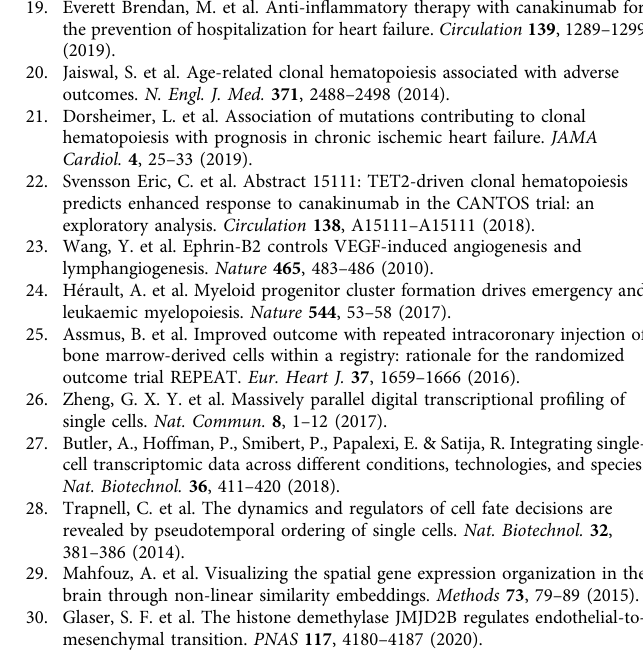
Fig. 4 Anti-IL-1 β treatment ameliorates the loss of type H vasculature in the bone after MI. a Schematic of the experimental design. b Flow cytometry analysis of femur bone marrow. Left, gating strategy; right, quanti fi cation. The numbers shown within the gates represent the percentages of events (cells) within that gates relative to the corresponding parent gate. The numbers shown within the gates represent the percentages of events (cells) within that gates relative to the upstream parent gates (CD45 neg Ter119 neg for CD31 pos cells and CD31 pos cells for Type H and Type L EC subsets, accordingly) (red). Type H endothelial cell number is increased upon anti-IL-1 β treatment (MCC950), while the total number of endothelial cells is not affected. N = 9 for PBS and N = 10 for MCC950. Data are shown as mean ± SEM, normalized to PBS. P -value was calculated by unpaired, two-tailed Student ’ s t -test (type H endothelial cell number) and two-tailed Mann – Whitney test (total number of endothelial cells). EC,# endothelial cells, BM EC, bone marrow endothelial cells (green). The total number of long-term hematopoietic stem cells (LT-HSC) remains unchanged after IL-1 β treatment. N = 9 PBS and N = 10 MCC950. Data are shown as mean ± SEM. P -value was calculated by unpaired, two-tailed Student ’ s t -test. LSK, Lin – Sca-1 + c-kit + cells ( c ) and ( d ) Immunostaining of longitudinal femur sections. c The length of type H vessels (dashed line) is longer upon MCC950 treatment 28 days after MI. N = 7 for PBS and N = 6 for MCC950. Data are shown as mean ± SEM. P -value was calculated by unpaired, two-tailed Student ’ s t -test. d CD41 + myeloid progenitor cell number is decreased in the bone marrow of MCC950-treated animals after myocardial infarction. N = 5 PBS and N = 6 MCC950. Data are shown as mean ± SEM. P - value was calculated by unpaired, two-tailed Student ’ s t